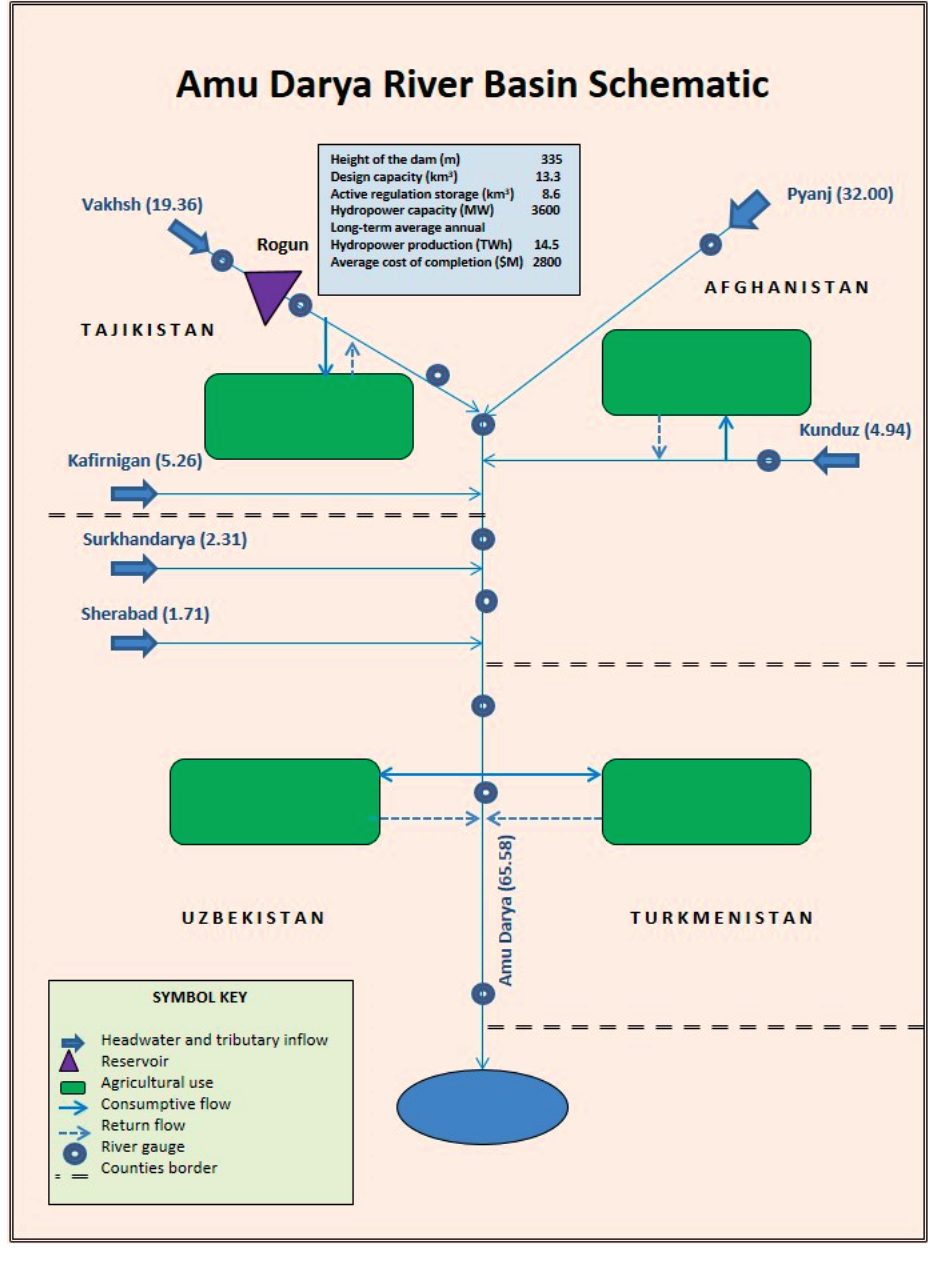
Figure 2. The schematic of the ADRB, including the design characteristic of the Rogun Hydropower Plant [9] and average annual water flow (billion cubic meters/year) of the Amu Darya tributaries used in the model